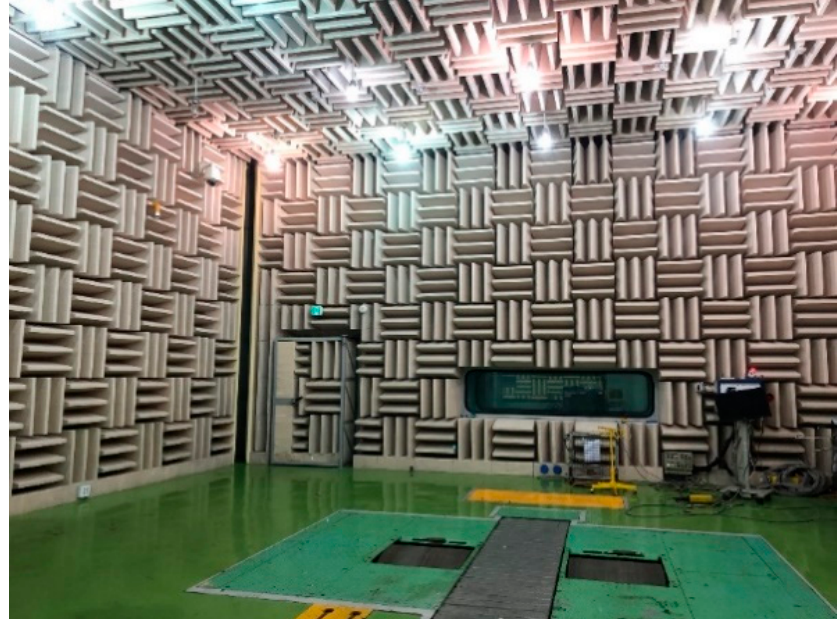
Figure 1. Semi-anechoic room and dynamometer for sound recording. 148